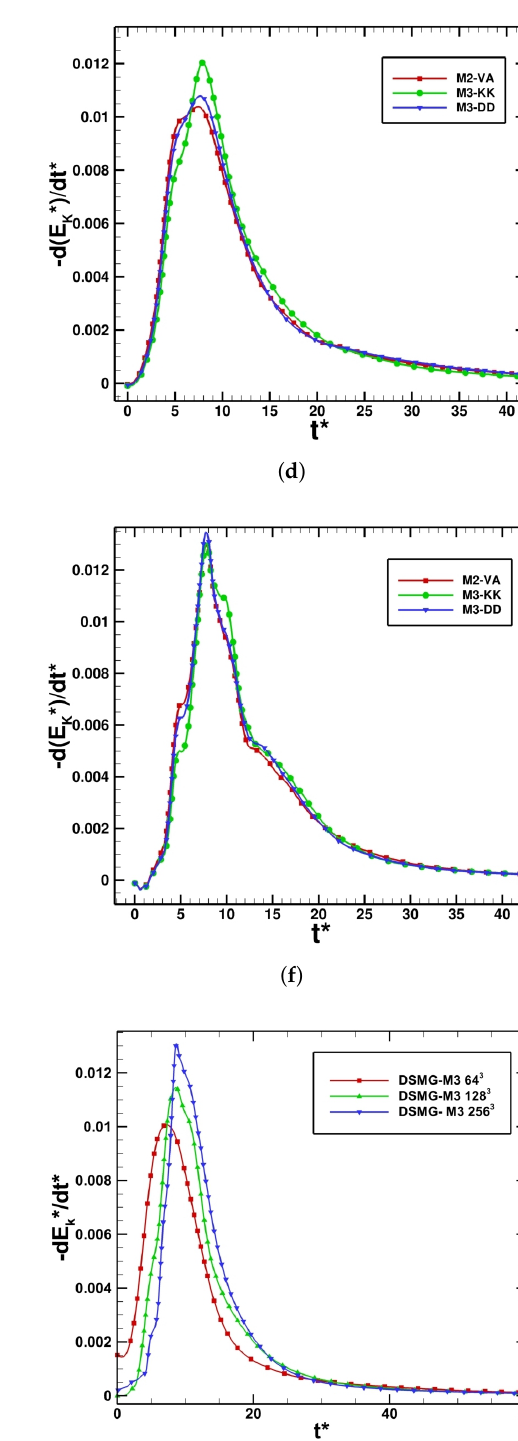
(43 3 ); ( b ) ILES, − dE ∗ / dt ∗ (43 3 ); ( c ) ILES, E ∗ (64 3 ); K k k (96 3 ); ( f ) ILES, − dE ∗ / dt ∗ (96 3 ); ( g ) LES, E ∗ ; ( h ) LES, − dE ∗ / dt ∗ K K K k